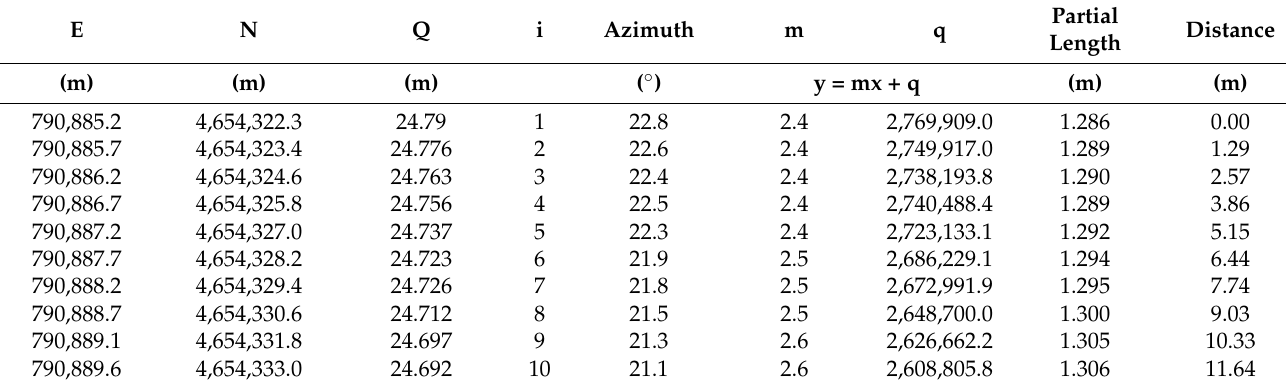
Figure 6. Example of Azimuth: heading angle from the magnetic north. Table 1. Information related to each vertex of the graph.